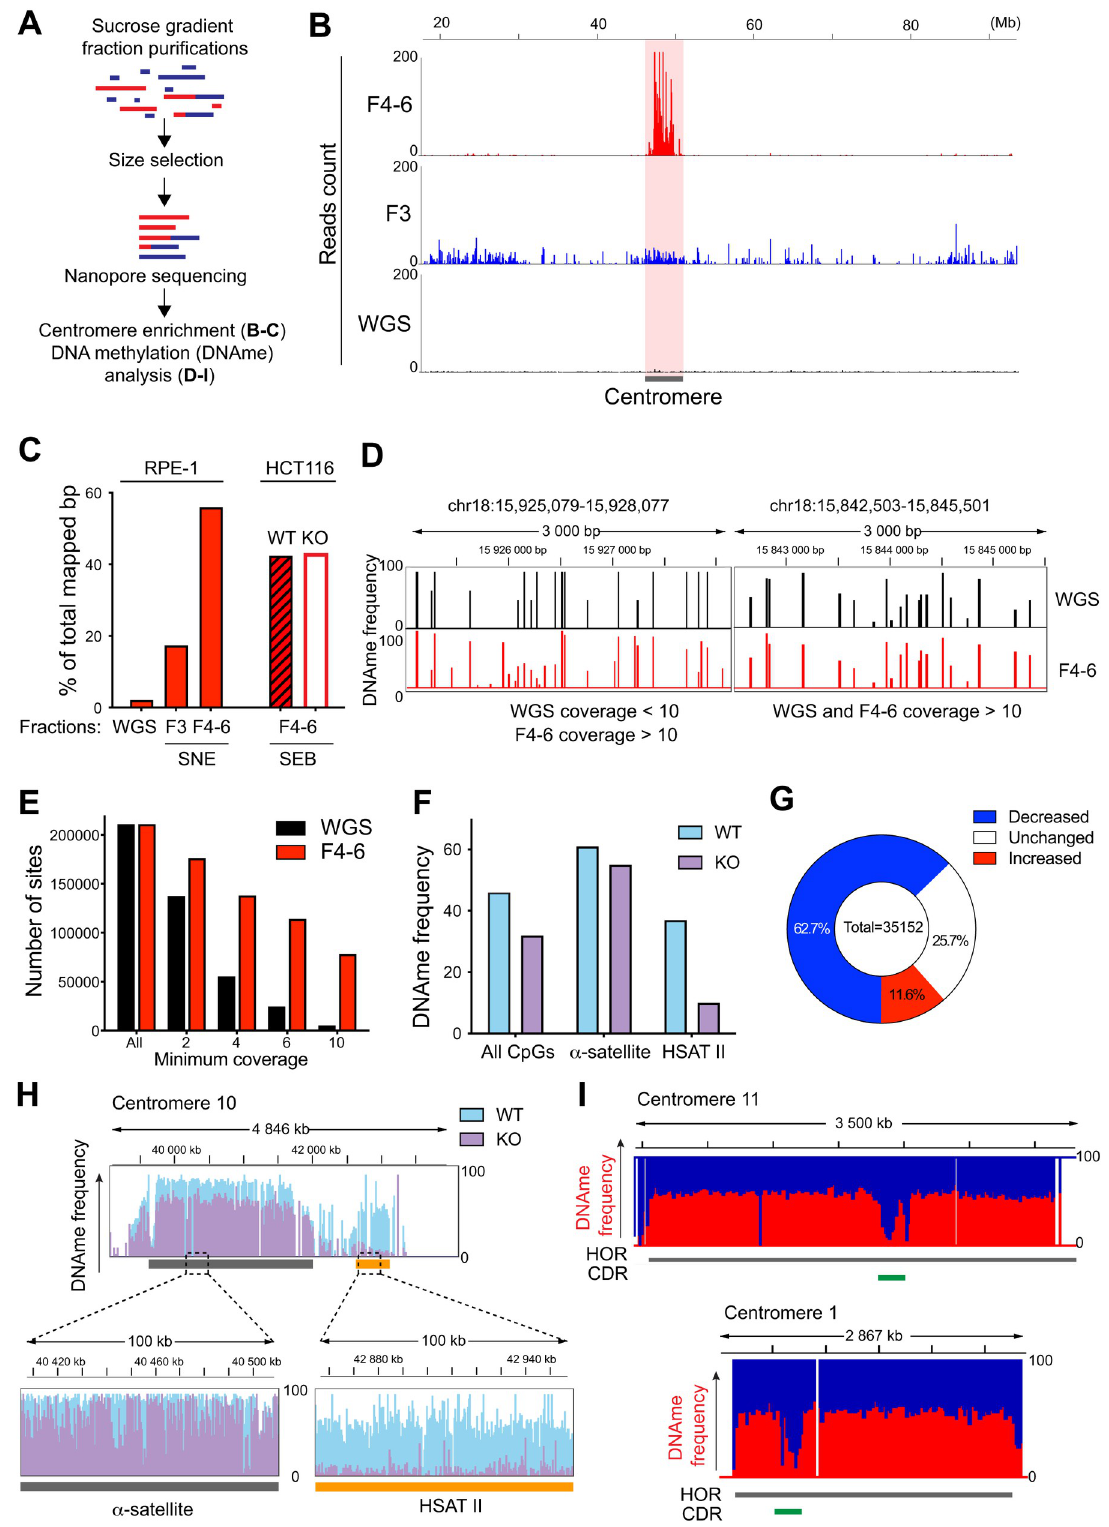
Fig 4. CenRICH is suitable for long read sequencing and DNA methylation analysis. A . Schematic representation of the experimental design. B. Coverage profiles of the centromeric region of chromosome 5 after Nanopore sequencing of an undigested sample